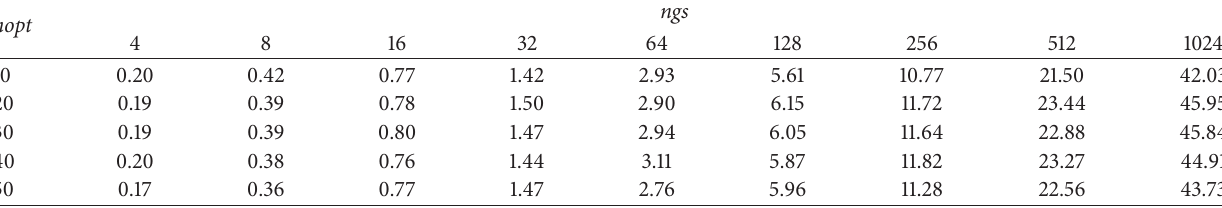
Table 5: Speed-up ratio of the CUDA-SCE-UA versus the Serial-SCE-UA.